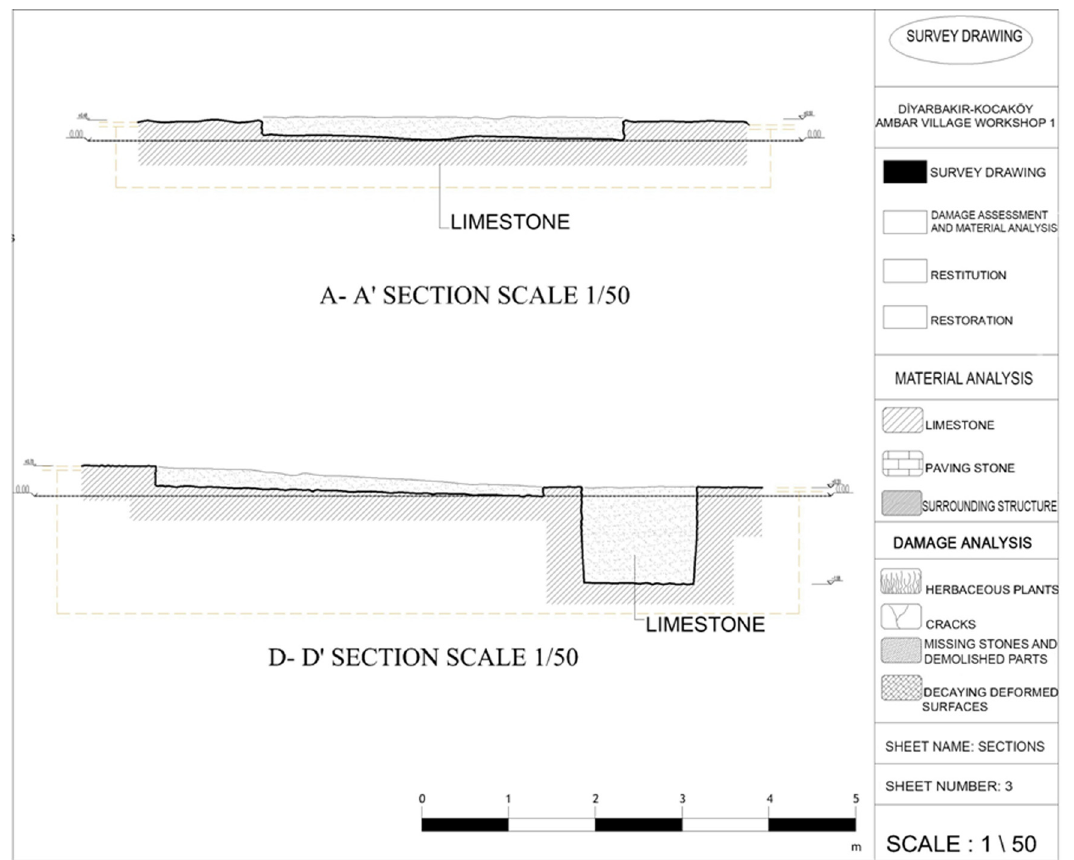
Figure 5: 1/50 Scale D - D ’ Section of WS1 ( Ambarçay Salvage Excavation Archive )